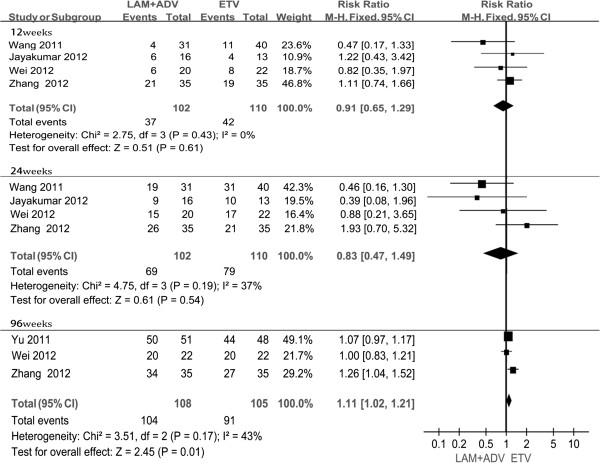
Effect of LAM + ADV vs. ETV on biochemical response.